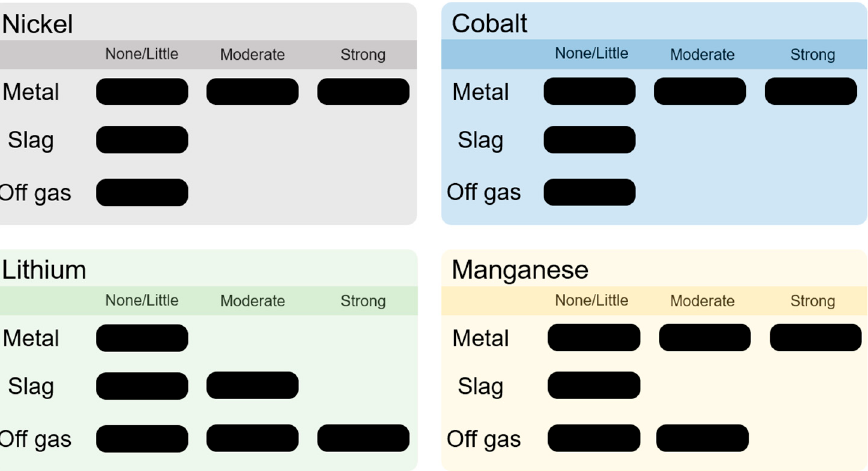
Figure 11. Qualitative consideration of the accumulation of Ni, Co, Mn and Li in the product phases obtained from the InduMelt experiments.